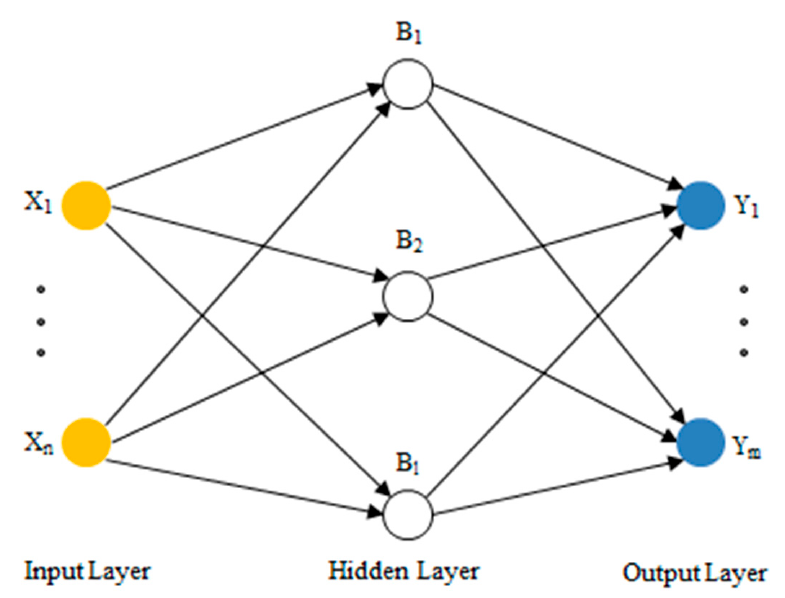
Figure 2. Single hidden layer neural